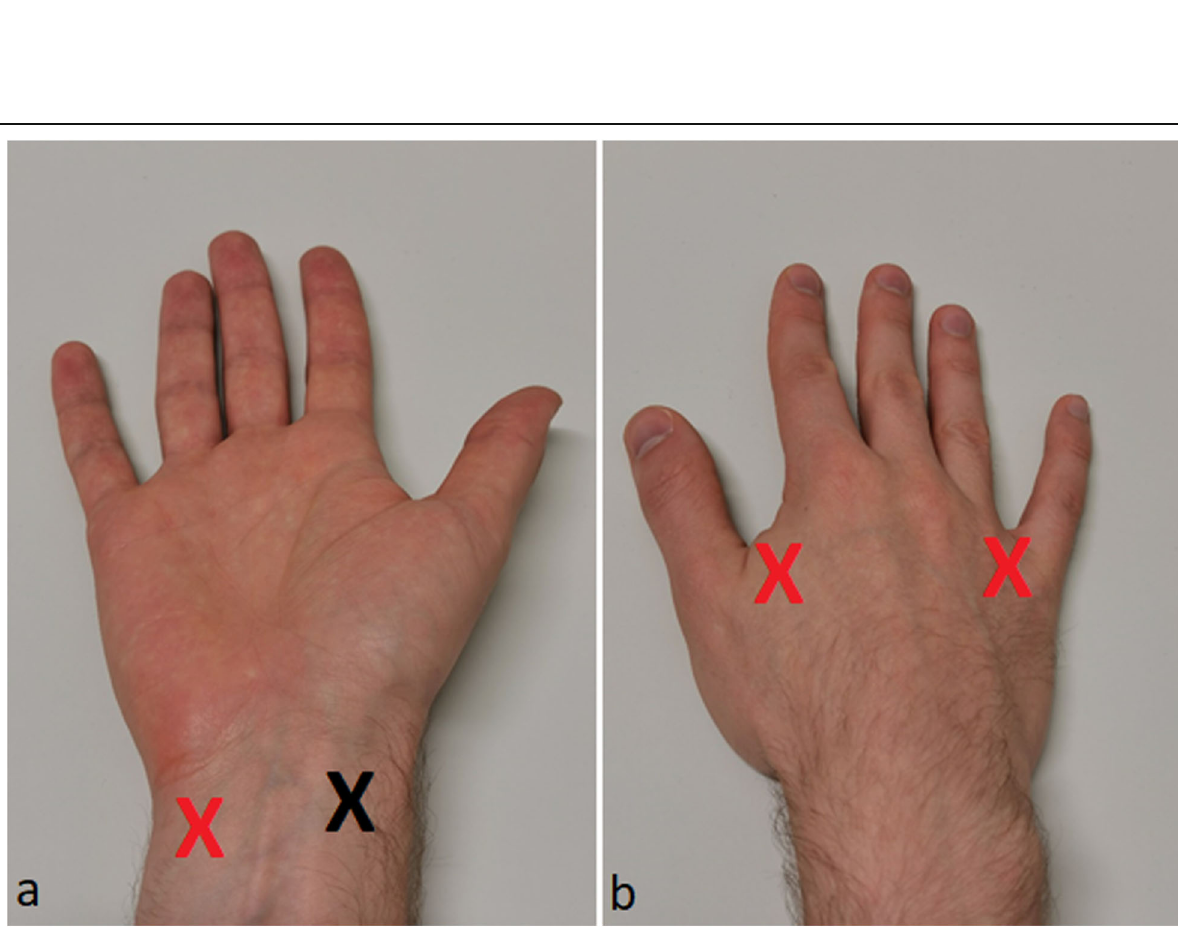
Fig. 2 The black X in a marks the primary injection site in the distal antebrachium. Additional injection sites are marked with a red X in a and